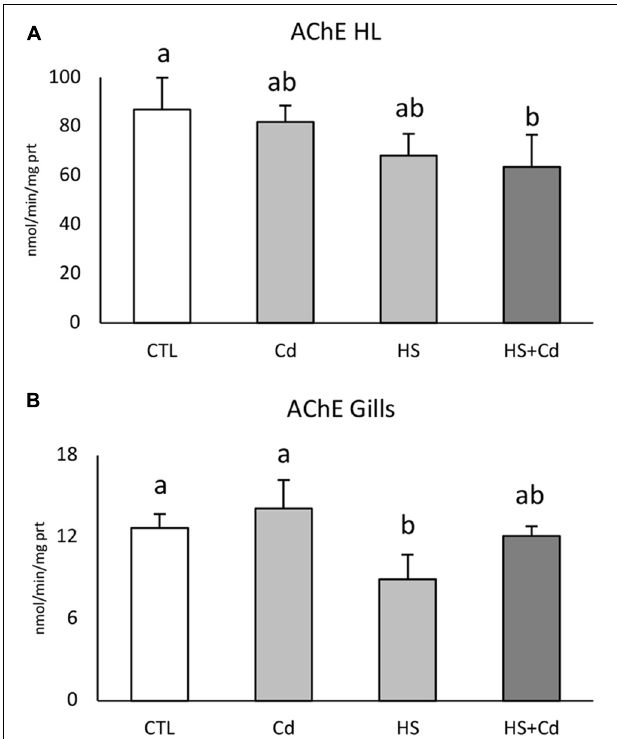
FIGURE 2 | Total oxyradical scavenging capacity toward peroxyl (TOSC ROO • , A ) and hydroxyl (TOSC HO • , B ) radicals in gills of exposed organisms. Values are given as TOSC units/mg of proteins, mean ± standard deviation, n = 4. Letters are used to highlight significant differences between group of means, CTL, Control; Cd, Cadmium exposure; HS, heat stress; HS + Cd, Cadmium exposure under heat